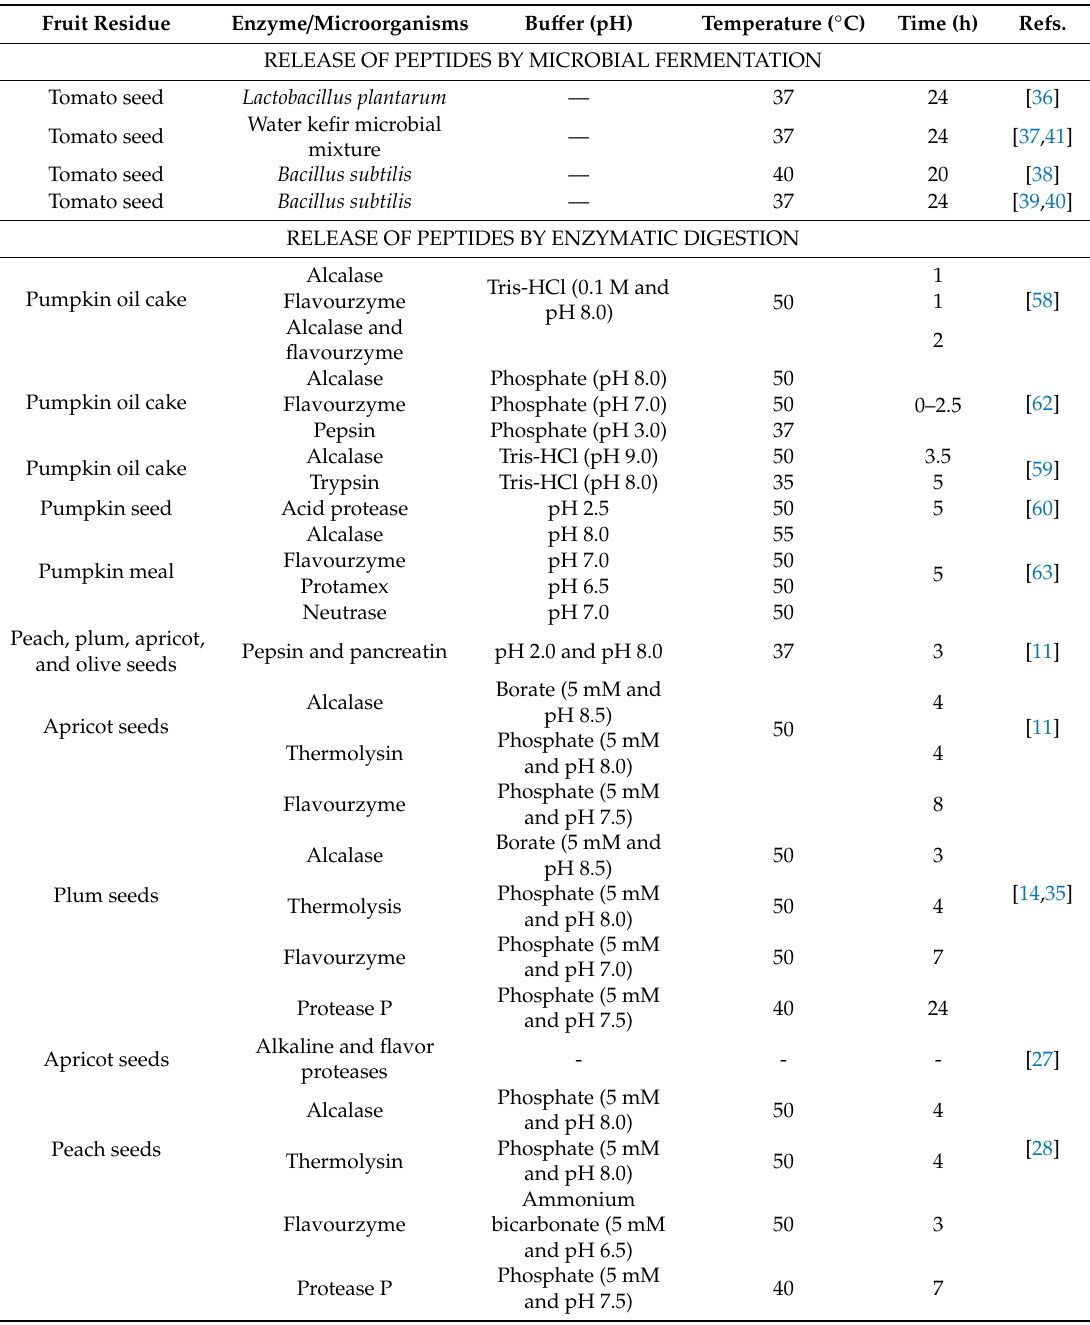
Table 2. Conditions employed to obtain antioxidant peptides from fruit